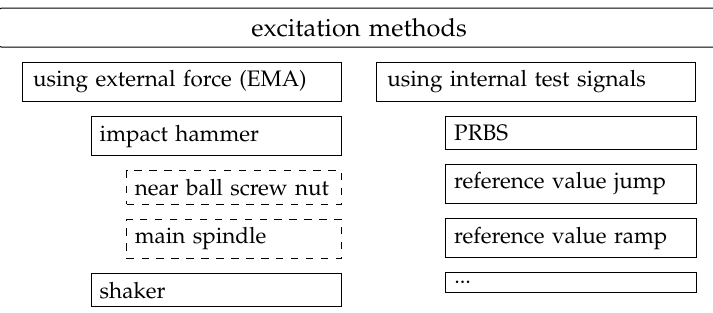
Figure 2. Overview about the excitation